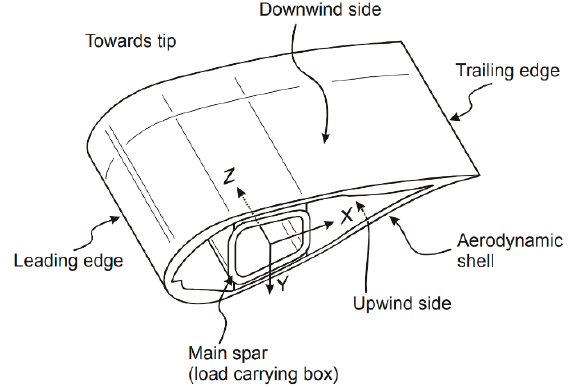
Figure 2. Blade of the wind turbine [37].